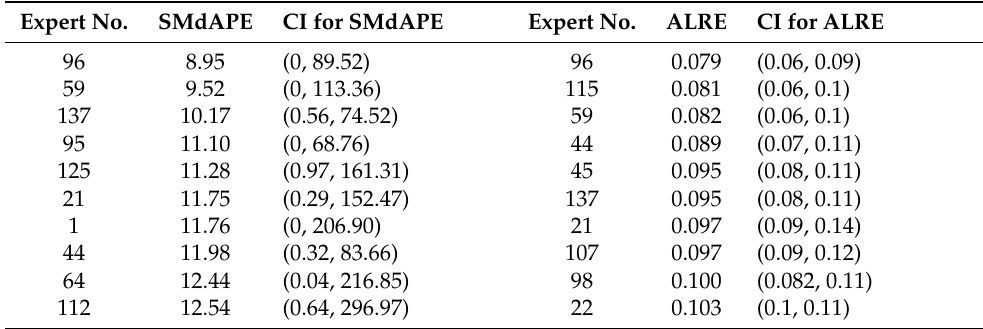
Table 6. The accuracy of the 10 worst performers who answered questions in at least three years, under two accuracy measures. For ALRE which is an average score we can calculate the 90% confidence intervals. For SMdAPE, which is a median, we report the 5 th and the 95 th percentiles forming the 90% credible interval. We denote both credible and confidence intervals by CI. Expert 999 is the Australian Treasury forecast.